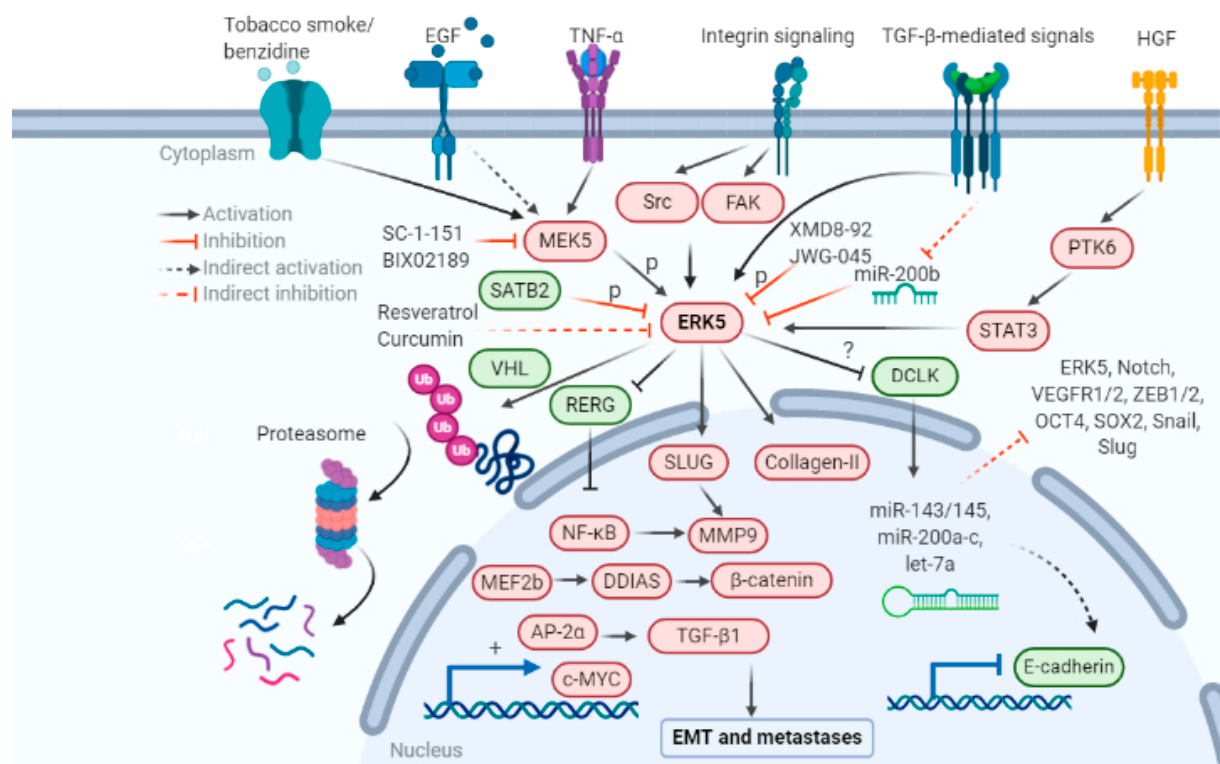
Figure 2. Upstream and downstream regulators of ERK5-mediated EMT. ERK5 activation is regulated by growth factors, integrins, and carcinogens such as tobacco smoke. Activation or overexpression of ERK5 can regulate gene expression of several mesenchymal genes, leading to suppression of E-cadherin and subsequent activation of the EMT program in cancer. Inhibitors of the MEK5-ERK5 cascade known to inhibit or reverse EMT are also included in the figure. Created with BioRender.com.